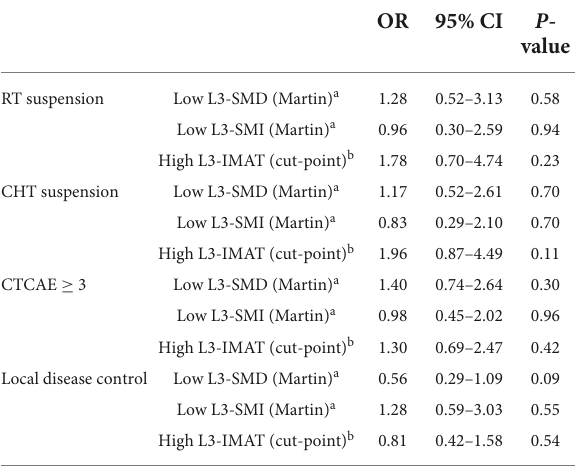
TABLE 3 Univariate logistic regressions between low muscle quantity and low muscle quality with short-term